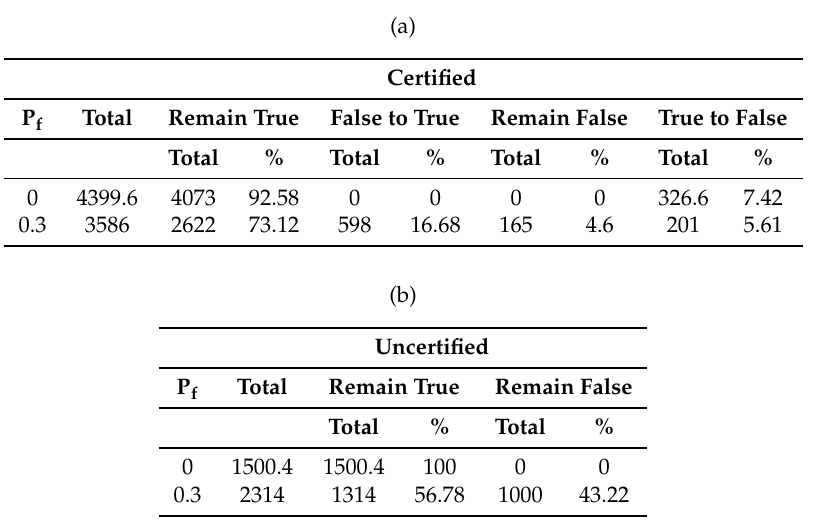
Table 5. Detailed statistics for delivered notifications in the simulation of the collaborative